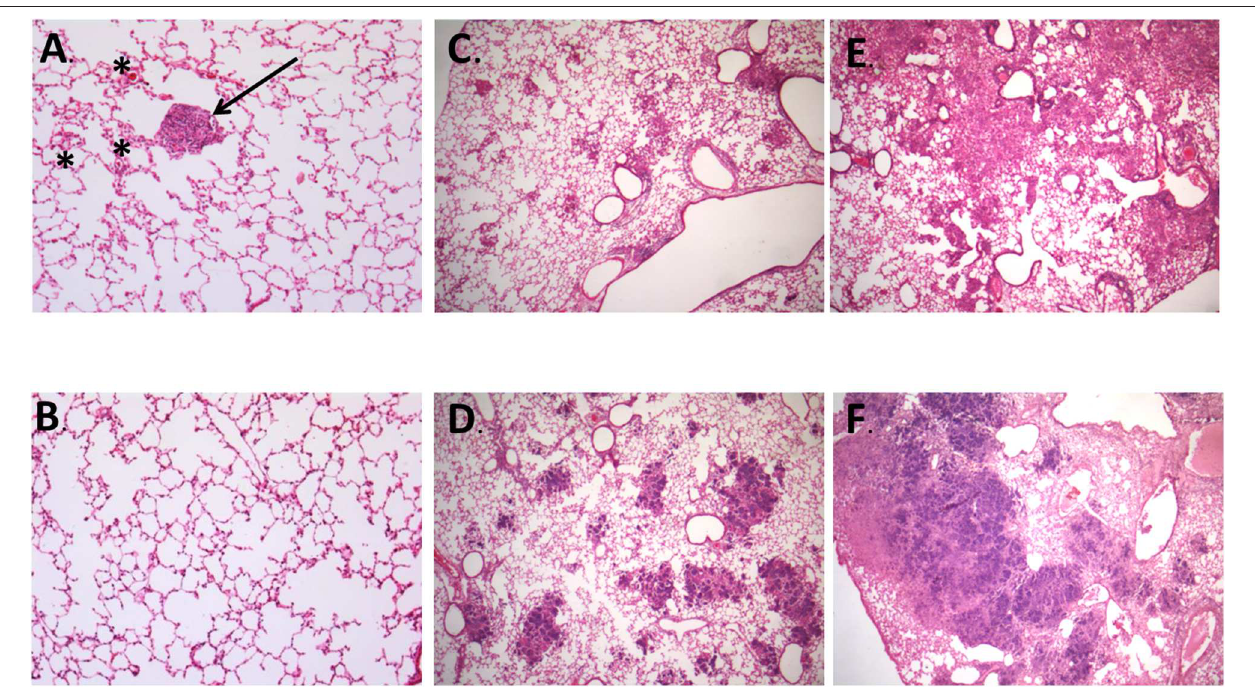
FIGURE 4 | Representative images of histopathological findings in animals infected by strain 46 and strain 46P. (A) Animals infected by strain 46 had early formation of granulomas (arrow) and interstitial inflammation, since day 7 post-infection (100X magnification). (B) Representative image of animals infected by strain 46P at day 7 postinfection, without formation of granulomas and very scarce if any interstitial inflammation (100X magnification). (C) On day 21 postinfection, animals infected by strain 46 had small pneumonic areas throughout the lung tissue (25X magnification). (D) Animals infected by strain 46P, instead, had larger pneumonic and necrotic areas by day 21 postinfection (25X magnification). (E) By day 28 postinfection, animals infected by strain 46 had larger, confluent pneumonic areas, with scarce areas with necrosis (25X magnification). (F) Contrary, animals infected by strain 46P had large areas of massive pulmonary necrosis which occupied most of the lung tissue (25X magnification). Stained with hematoxylin and eosin. * areas of interstitial inflammation.